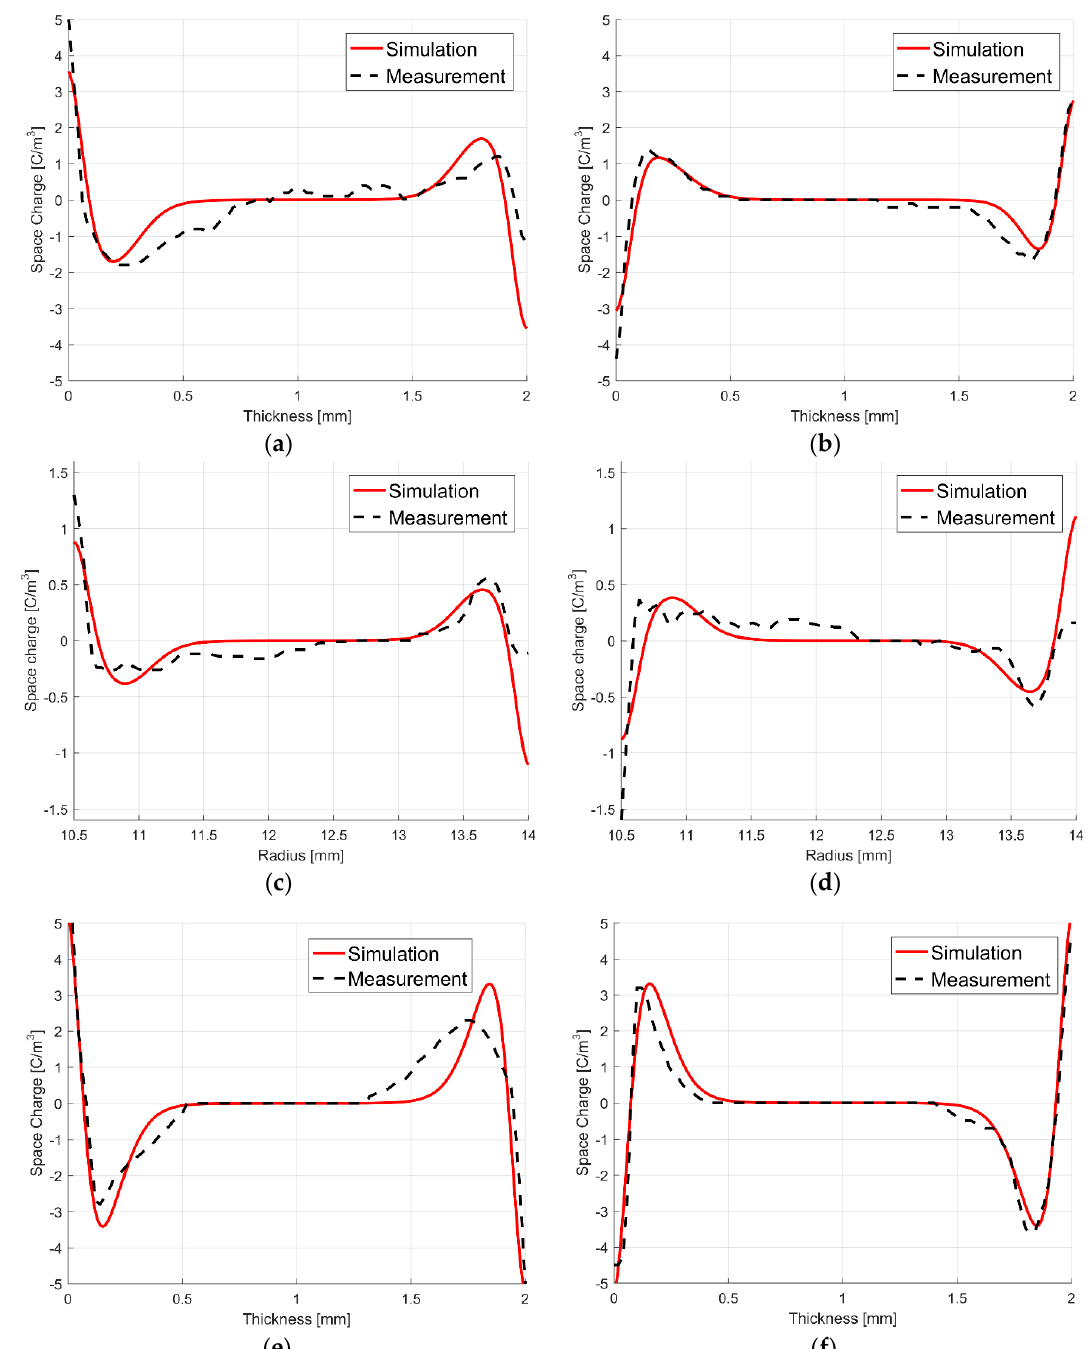
Figure 6. Measured and simulated charge distribution in a XLPE and LDPE insulation [6]. ( a ) XLPE, planplanar, + U ; ( b ) XLPE, planplanar, − U ; ( c ) XLPE, cylindrical, + U ; ( d ) XLPE, cylindrical, − U ; ( e ) LDPE, planplanar, + U ; ( f ) LDPE, planplanar, − U . The absolute value of the applied voltage is | U | = 20 kV.